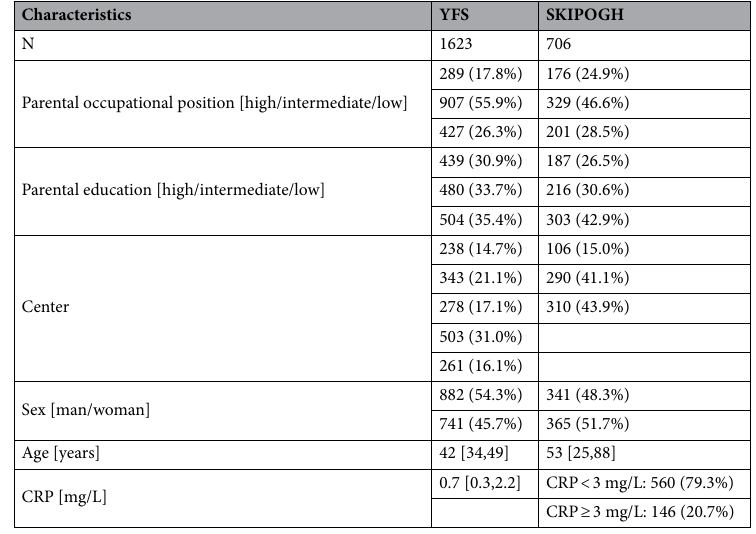
Table 1. Characteristics of the YFS and SKIPOGH populations. Participants are those with complete information about parental occupational position, transcriptome and CRP. Categorical characteristics are summarized through their absolute and relative (%) prevalence. Age is summarized through its mean and range. CRP in YFS is summarized with median and lower to upper quintiles range, while in SKIPOGH is binarized as 3 mg/L is the highest left truncation value (see “Materials and methods” section).